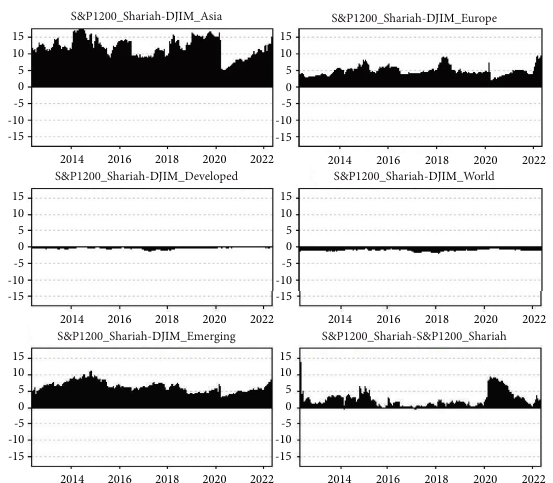
Figure 6: Dynamic pairwise spillovers between regional Shariah markets. Notes: dynamic net pairwise spillovers between regional Shariah markets are